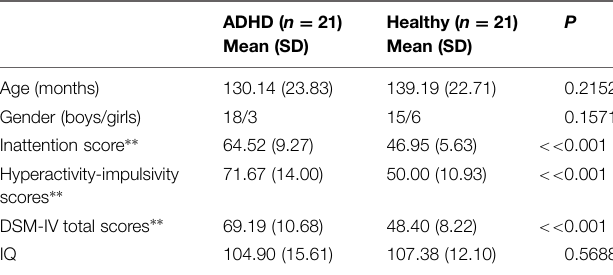
TABLE 1 | Demographic and clinical data of the healthy children and the children with attention-deficit/hyperactivity disorder